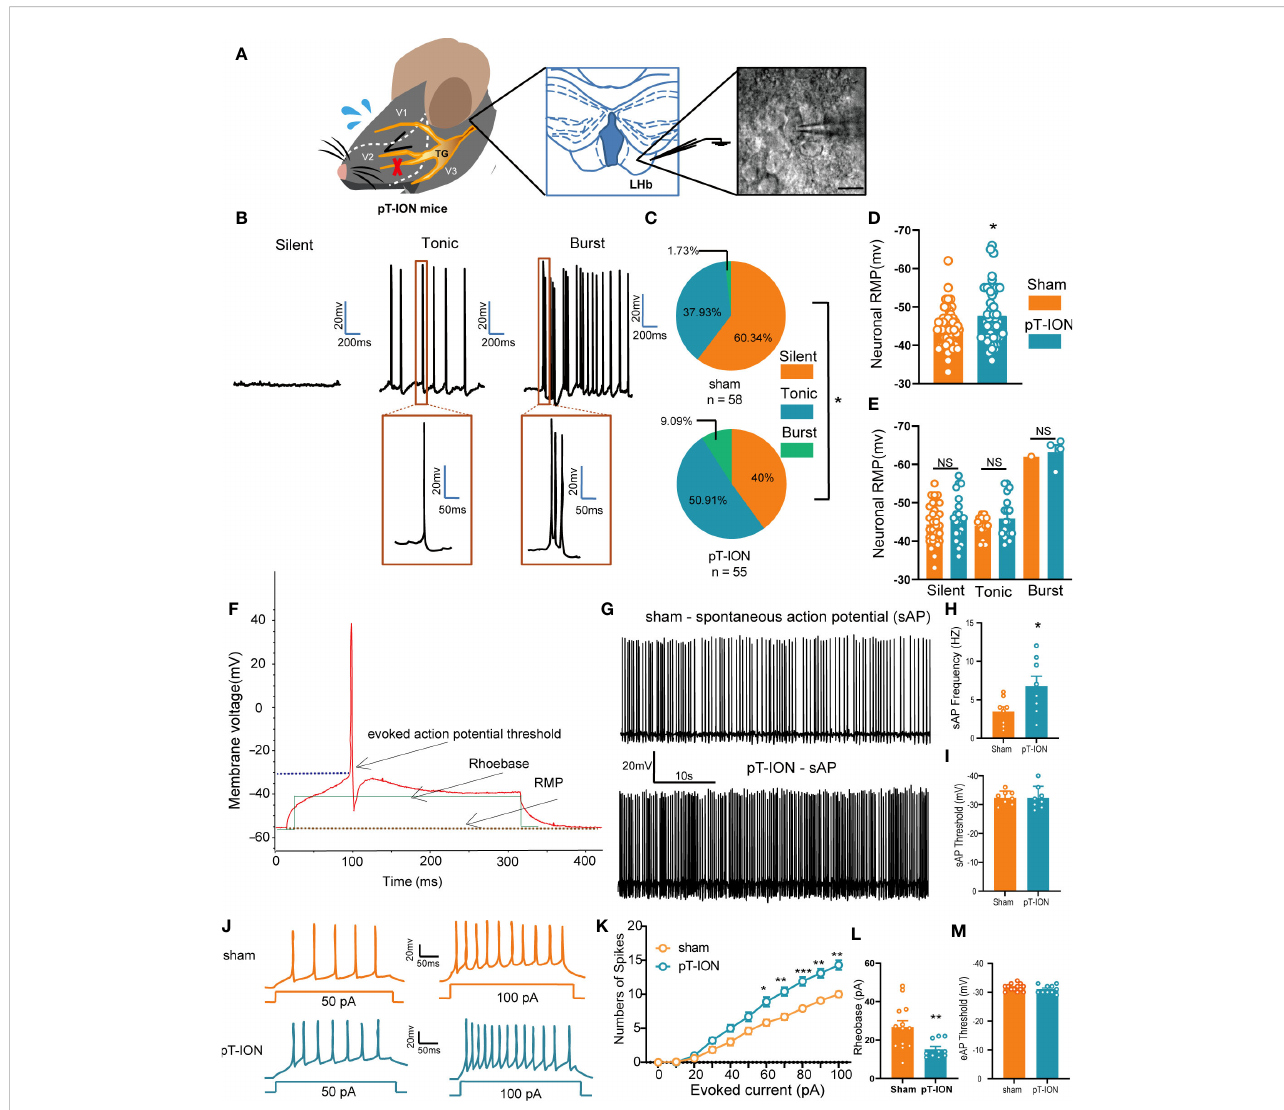
FIGURE 1 The LHb was activated in pT-ION mice. (A) Schematic of the trigeminal nerve anatomy and innervated region showing the infraorbital branch and the pT-ION ligation and transection point (left). Schematic of the whole-cell patch clamp recording in the LHb of pT-ION mice (middle). Sample image showing LHb neurons under clamp (right). Scale bar, 10µm. (B) Representative traces of silent, tonic- fi ring, and burst- fi ring of LHb neurons. (C) Pie charts showing the percent abundance of the three types of LHb neurons in pT-ION and sham mice (*p < 0.05 by Chi squared test, n = 58 neurons from 11 mice in the sham group, n = 55 neurons from 12 mice in the pT-ION group). (D) The RMP recorded from LHb neurons of pT-ION and sham mice. (E) The RMP recorded from LHb neurons of pT-ION and sham mice and divided into three types: silent, tonic- fi ring, and burst- fi ring (n = 49 neurons from 10 mice in the sham group, n = 43 neurons from 10 mice in the pT-ION group). (F) Schematic of the action potential threshold, RMP, and rheobase (minimum current required to fi re an action potential). (G, H) Typical traces (G) and data of spontaneous action potential fi ring spikes (H) recorded from LHb neurons of pT-ION and sham mice (*p < 0.05 vs. sham). (I) Data of spontaneous action potential thresholds recorded from LHb neurons of pT-ION and sham mice (n = 8 neurons from 8 mice). (J) Sample traces of evoked action potentials recorded from the LHb neurons of sham or pT-ION mice. (K) Firing spikes recorded from the LHb neurons of pT-ION and sham mice (*p < 0.05, **p < 0.01, ***p < 0.001 vs. control, n = 35 neurons from 8 mice in the control group, n = 28 neurons from 8 mice in the pT-ION group). (L, M) Data of rheobase (L) and evoked action potential threshold (M) recorded from LHb neurons of pT-ION and sham mice (**p < 0.01 vs. sham, n = 13 neurons from 8 mice in the sham group, n = 10 neurons from 8 mice in the pT-ION